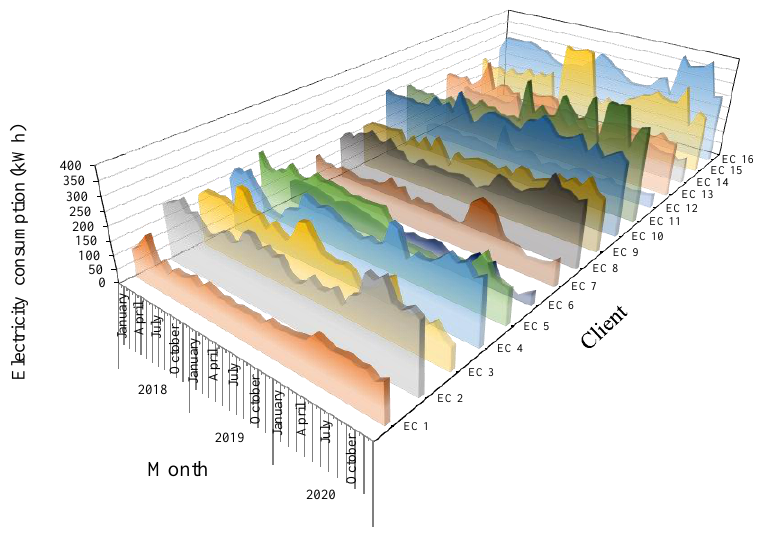
Figure 9. Electricity consumption by client. Arica: January 2018 to December 2020 (Source: Prepared by the authors).